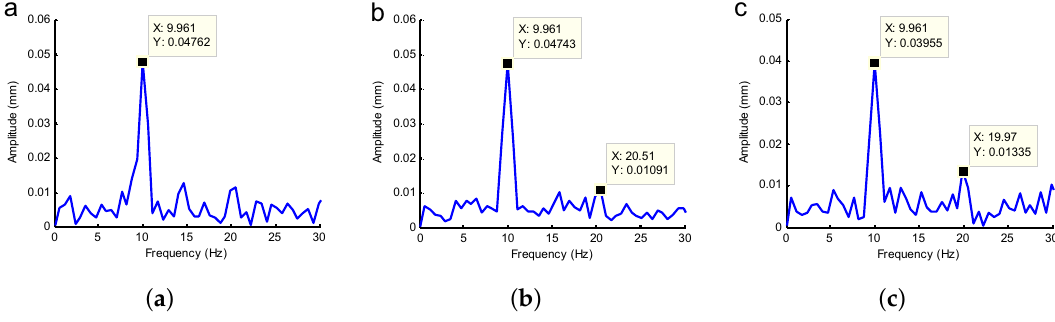
Figure 12. The frequency spectrum of out-plane displacement at rotation speed of 600 rpm: ( a ) without additional weight; ( b ) with 1g weight; and ( c ) with 2 g